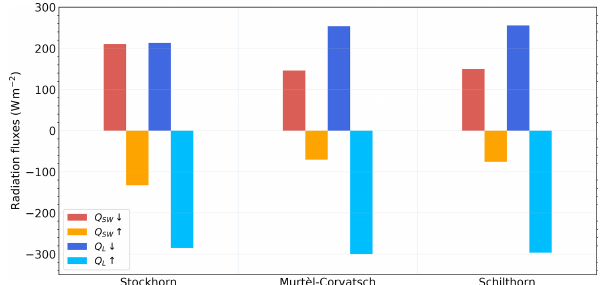
Figure 4. Radiation components for all three stations averaged over the observation periods: Murtèl–Corvatsch (1997–2018), Schilthorn (1999–2018) and Stockhorn